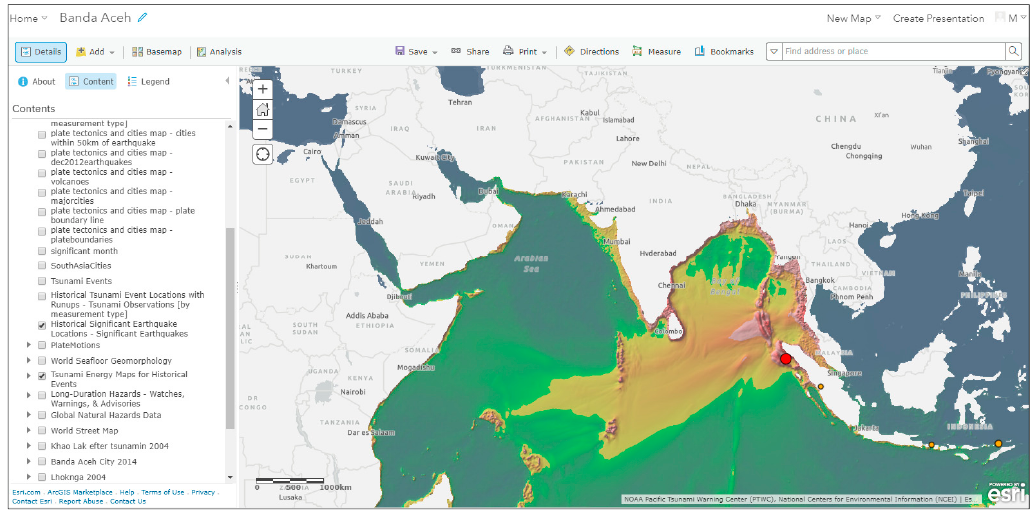
Figure 5. The artefact base map.